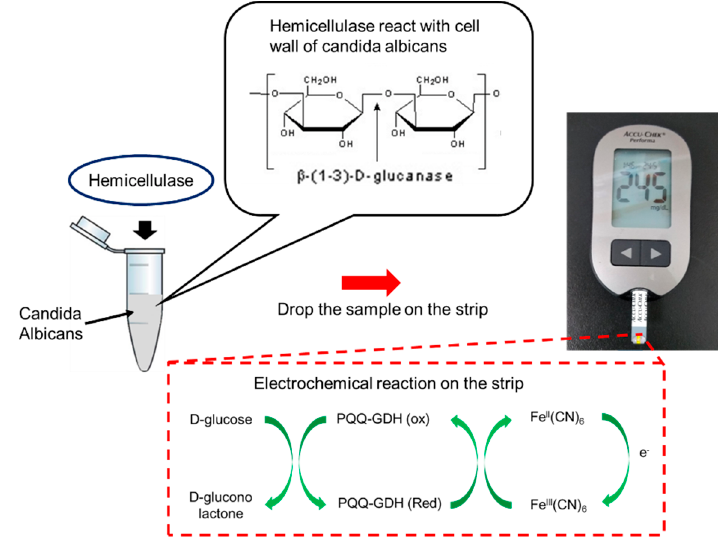
Figure 1. Mechanism of Candida detection. When adding hemicellulase into the sample, the cell walls of C. albicans will be broken down into oligo and glucose, which can be detected by a commercial glucose meter. PQQ—pyrroloquinoline quinone; GDH—glucose dehydrogenase; FeIII(CN) 6 —potassium hexacyanoferrate (III); FeII(CN) 6 —potassium hexacyanoferrate (II).